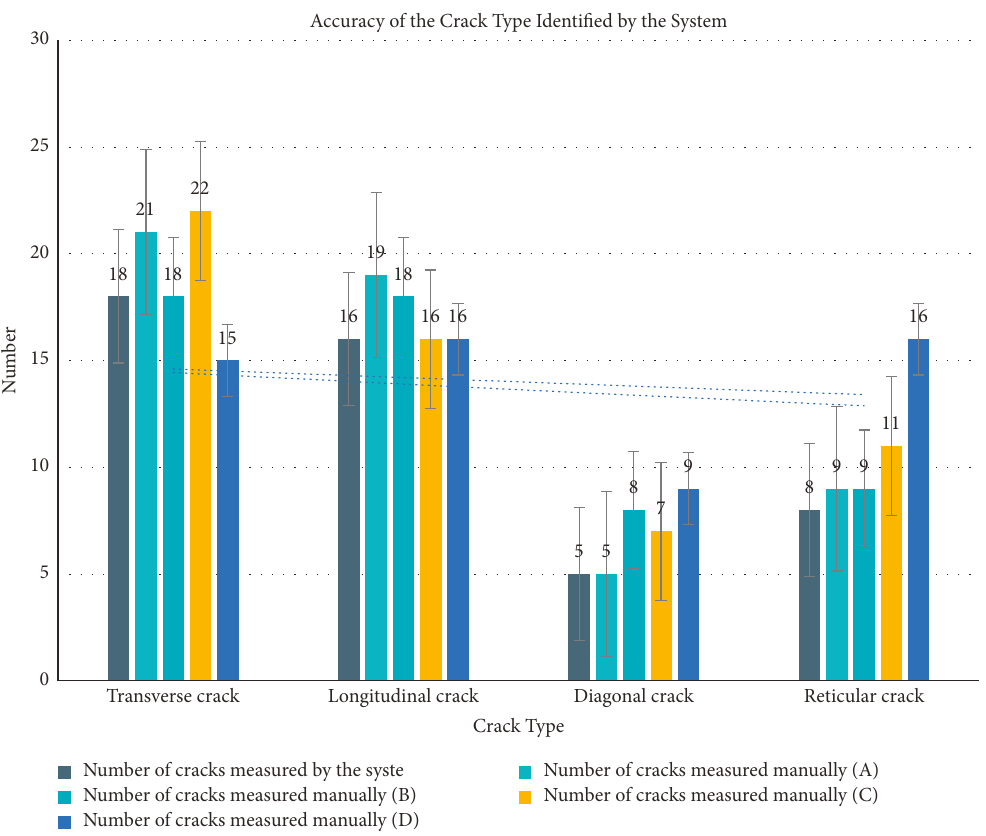
Figure 6: The result of the accuracy of the crack type identified by the